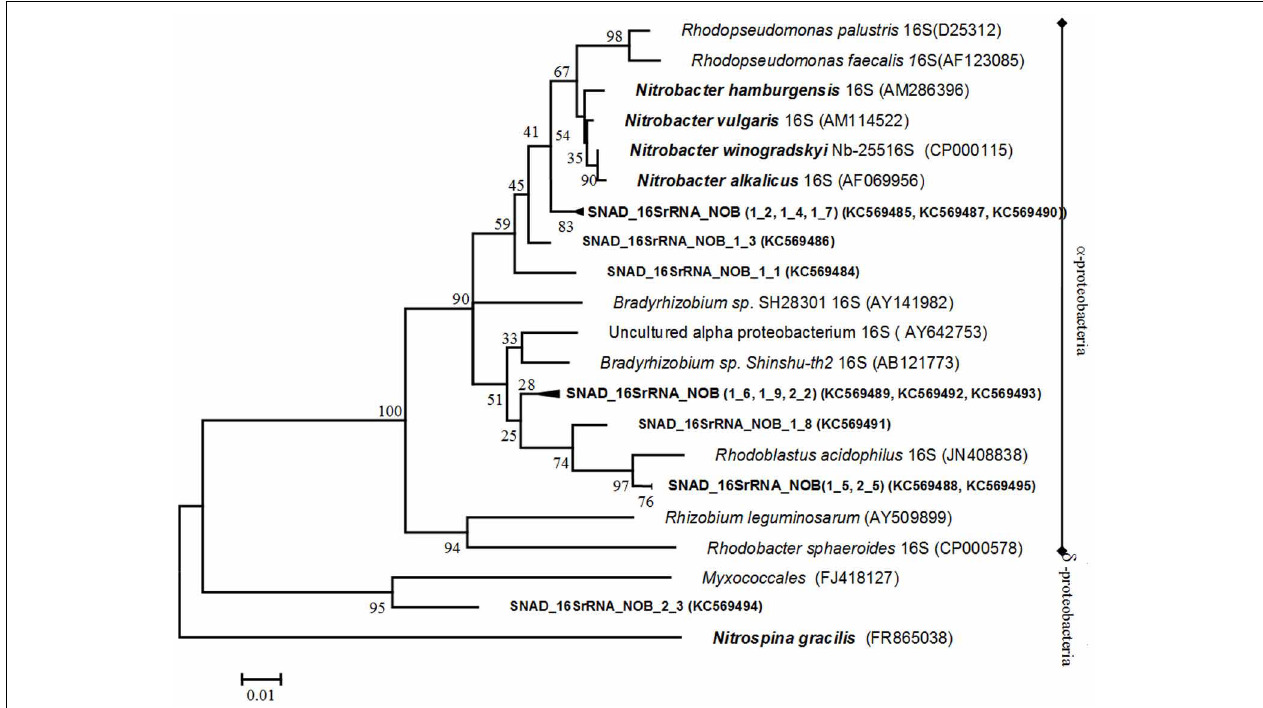
FIGURE 5 | Phylogenetic tree, based on 16S rRNA gene sequences of NOB. The tree shows the relationship of the clone sequences within the α - and δ - protobacteria, including both nitrite-oxidizing and non-nitrifying bacteria. Names of nitrite oxidizers are printed in bold and italics while clone sequences are in bold. The phylogenetic tree was constructed using the Neighbour—Joining method while the